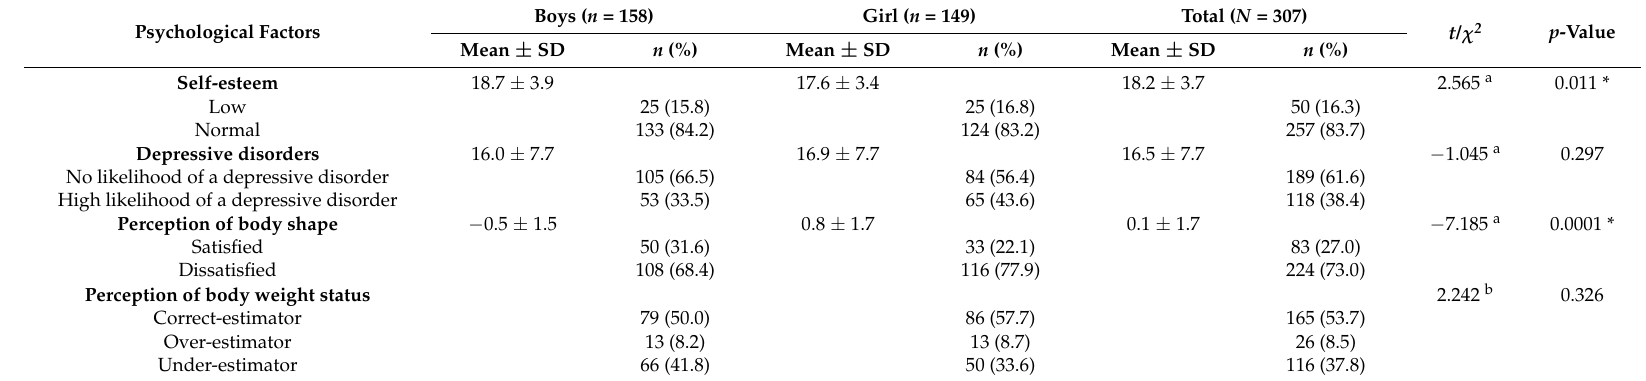
Table 1. Distribution of respondents according to psychological factors ( N =